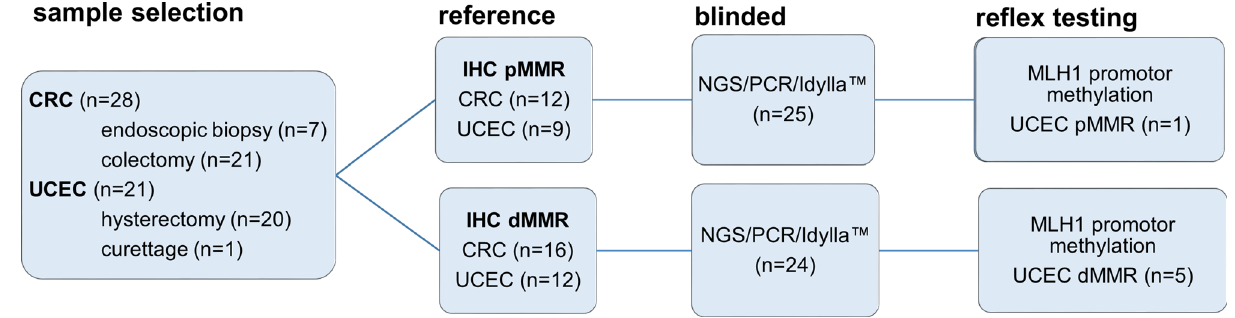
Figure 1. Flowchart of study design. Colorectal (CRC, n = 28) and uterine corpus endometrial cancers (UCEC, n = 21) were classified as DNA mismatch repair (MMR) deficient (dMMR) or proficient (pMMR) based on done for MLH1 promoter methylation after unblinding of IHC and molecular test